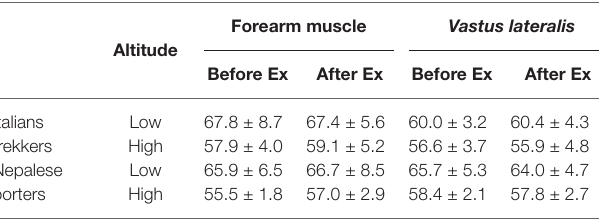
TABLE 3 | Tissue saturation index (TSI) values, obtained from NIRS measurement, before and after the exercise, clustered by ethnic group, muscle group, and